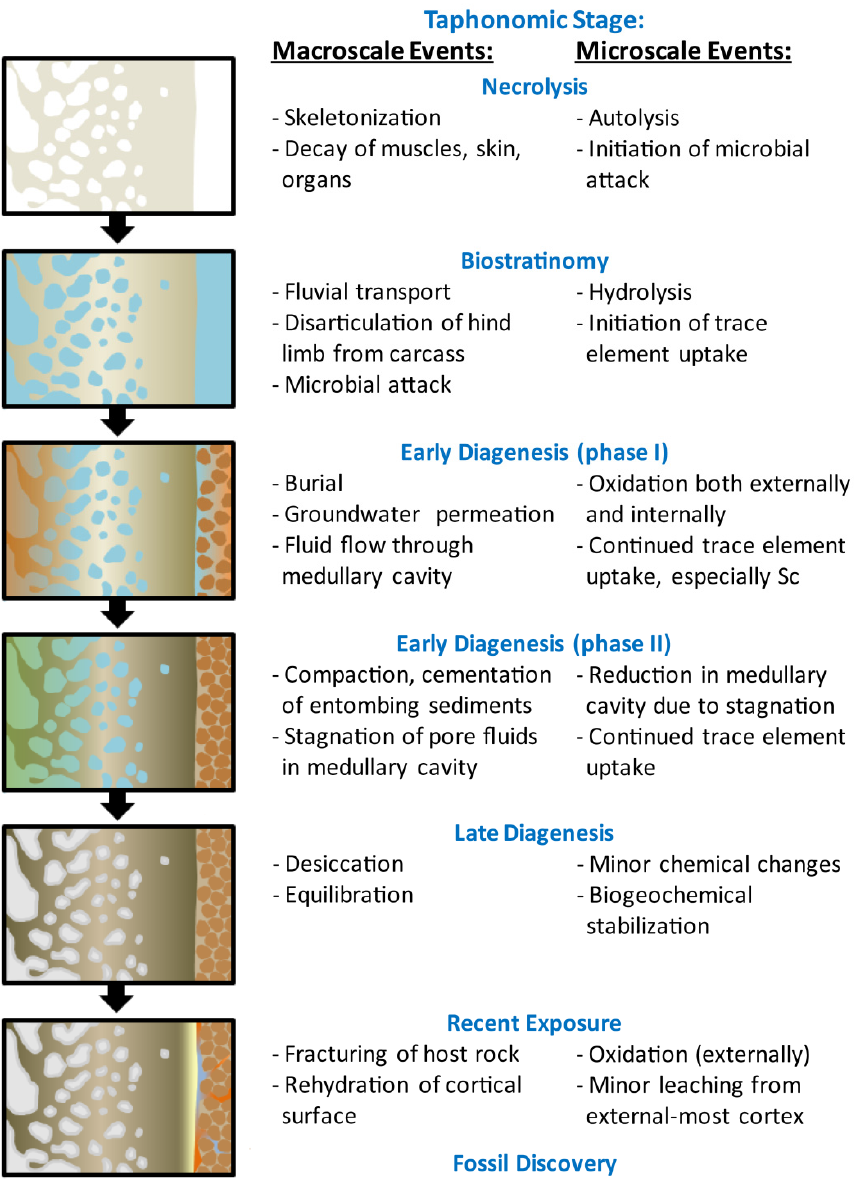
Figure 7. Reconstruction of the diagenetic history of Brachylophosaurus canadensis MOR 2598, sum- marizing macroscale and microscale events effecting its skeletal elements after death. Events are classified into approximate taphonomic stages, with a visual portrayal of the diagenetic processes affecting the bones during each stage shown at left.